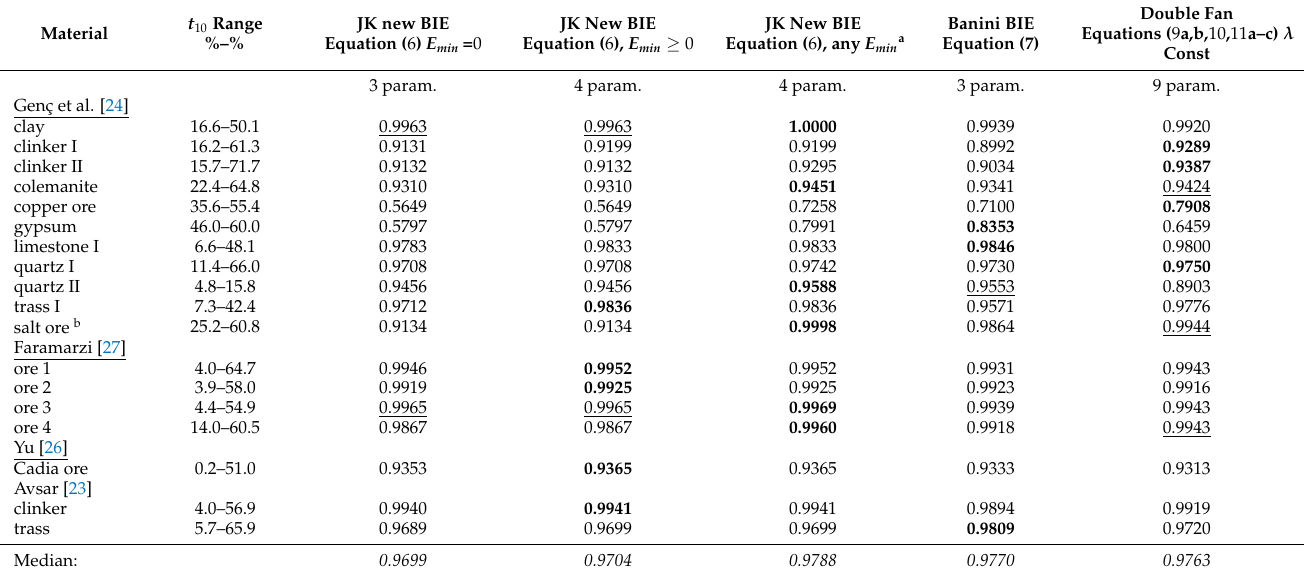
Table 5. t 10 fitting ranges and R 2 fidelities for different breakage index equations. Bold number: highest R 2 -value for that material; underlined number: highest R 2 if only E min ≥ 0 allowed.